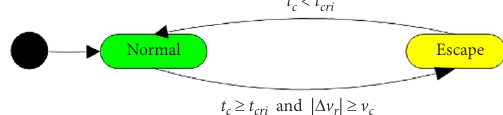
Figure 3. State machine (source: created by the